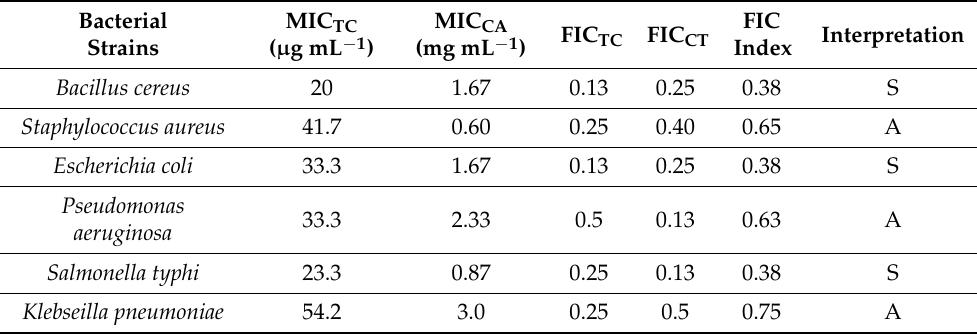
Table 3. M.I.C.s and F.I.C. indices of tetracycline (T.C.) in combination with chlorogenic acid (C.A.) against six pathogenic bacterial